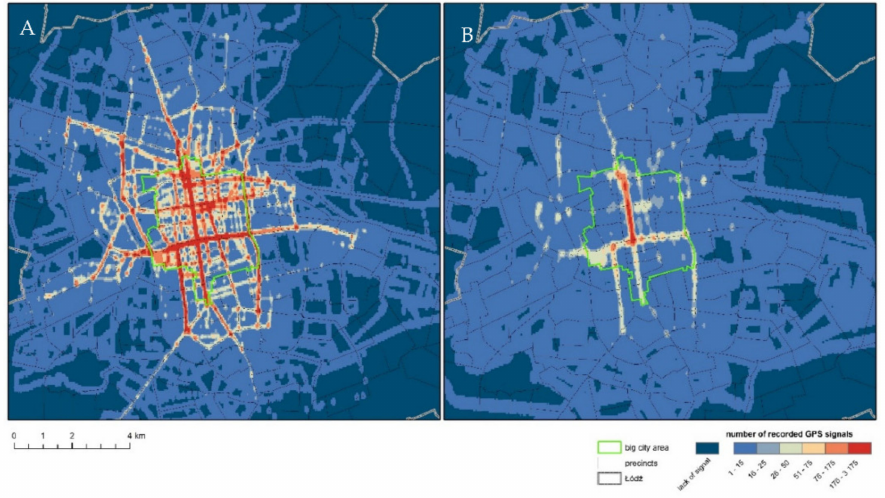
Figure 10. Spatial differentiation of ŁPB traffic density on workdays ( A ) and on weekends ( B ) in